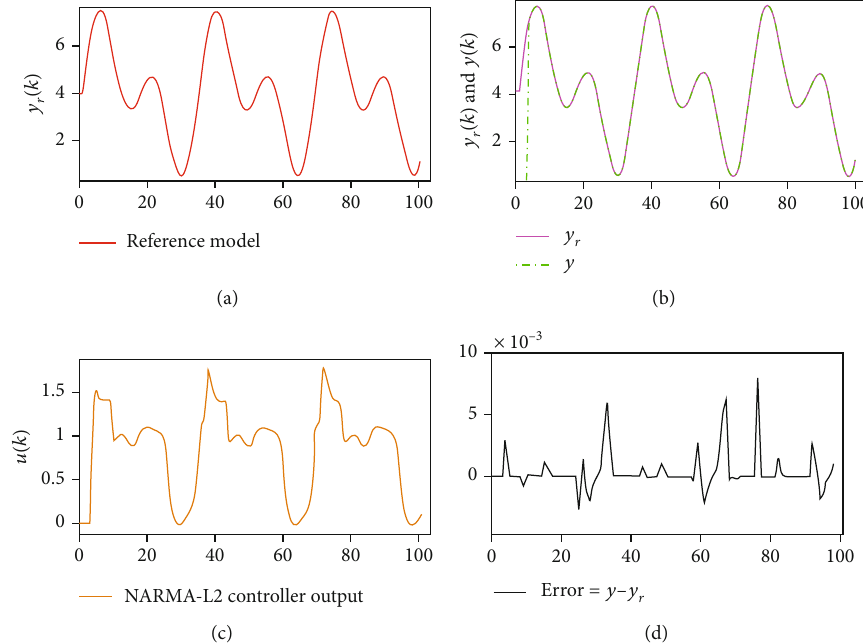
Figure 10: Example 2: (a) response of the reference model, (b) response of the plant under the NARMA-L2 controller, (c) NARMA-L2 controller output, and (d) control error with the NARMA-L2 model (using n = 3 and m = 2